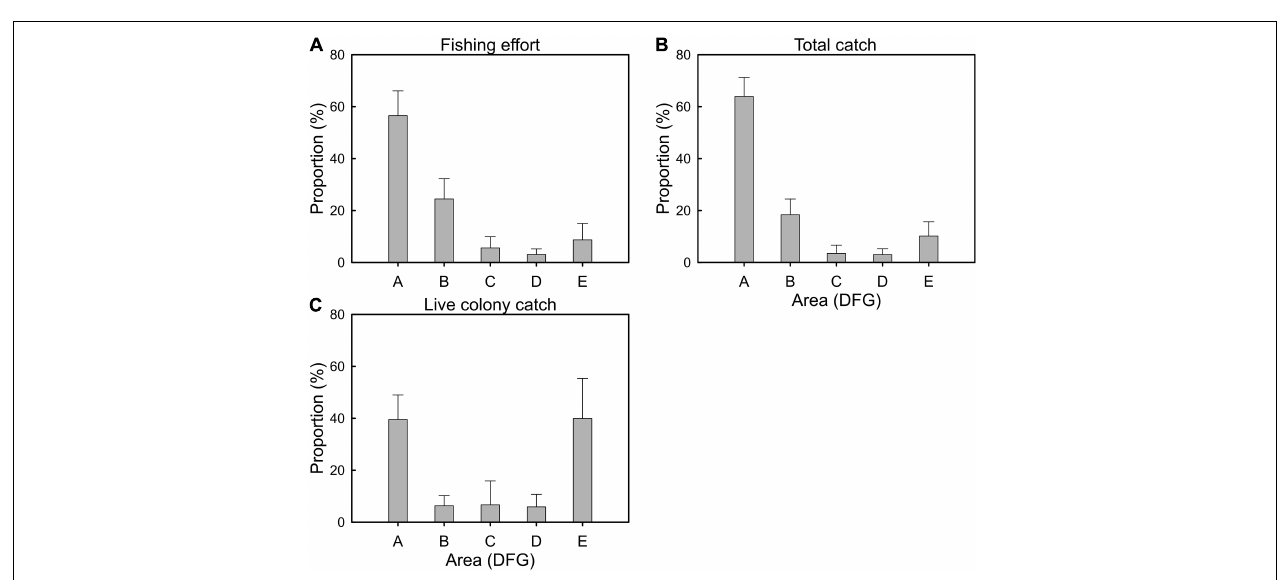
FIGURE 5 | Average annual proportion (%) of the five DFGs for the (A) fishing efforts, (B) total catches, and (C) live colony catches of the Taiwanese precious coral fishery between 2009 and 2018 (error bar, standard